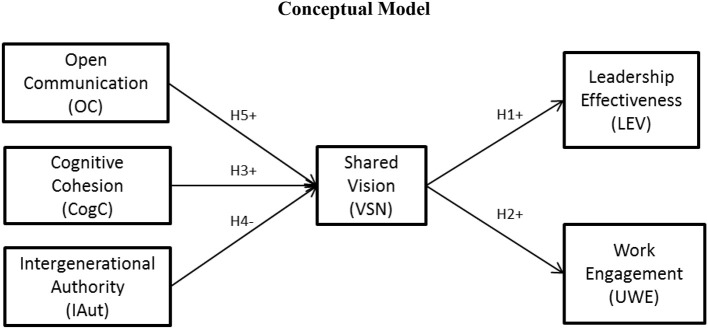
Conceptual Model.